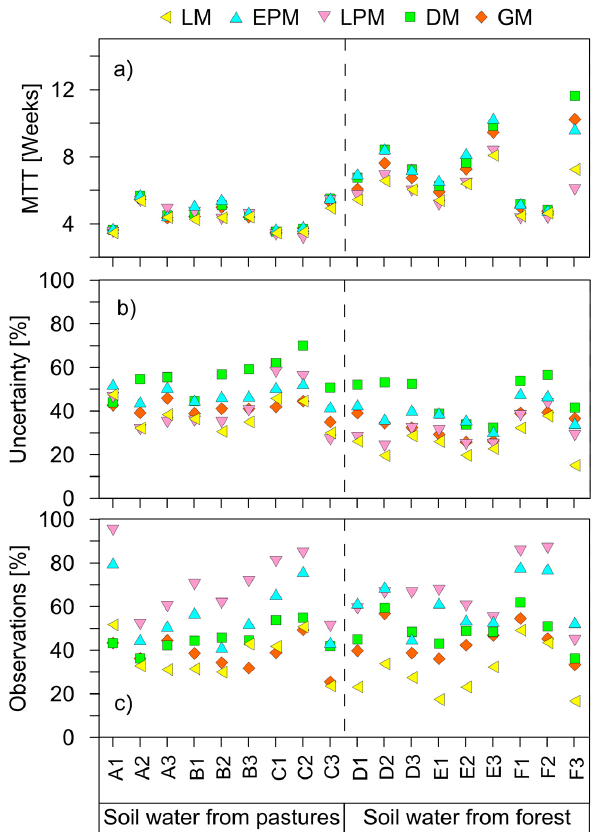
Fig. 6. Intercomparison of models for soil sites according to their (a) estimated mean transit times; (b) uncertainty ranges expressed in percentage of its respective MTT estimation; and (c) number of observations inside the range of behavioral